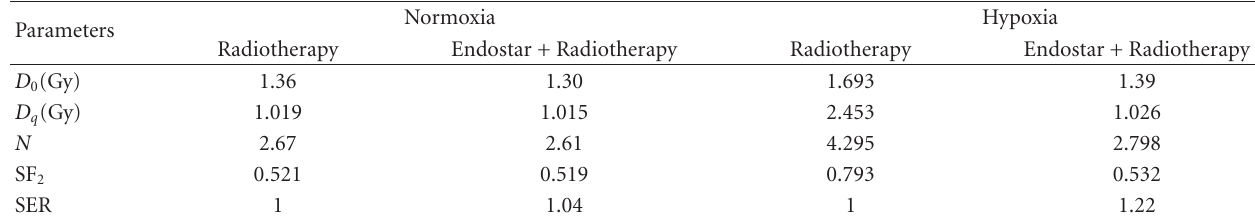
Table 3: Parameters of A549 cells in single-hit multitarget model under di ff erent conditions.